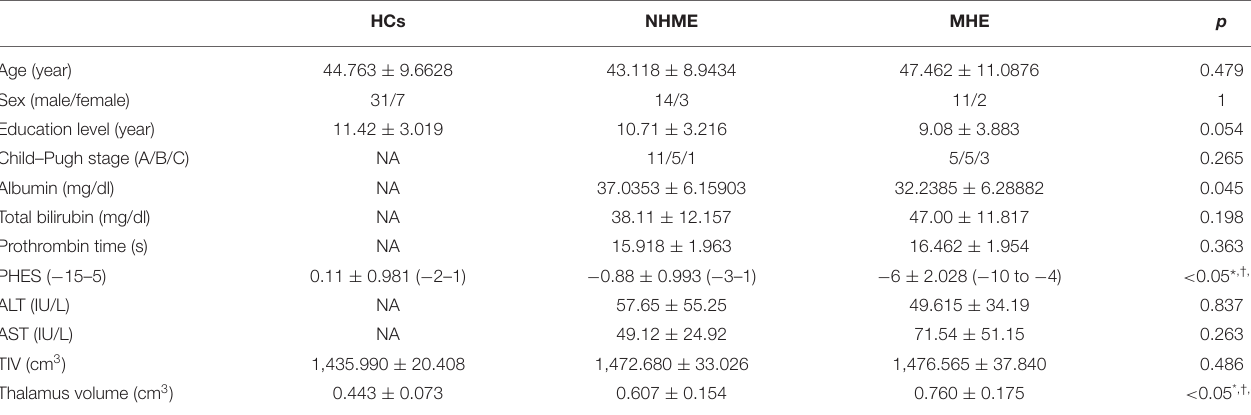
TABLE 1 | Demographic and neuropsychological characteristics of HCs and cirrhotic patients. HCs